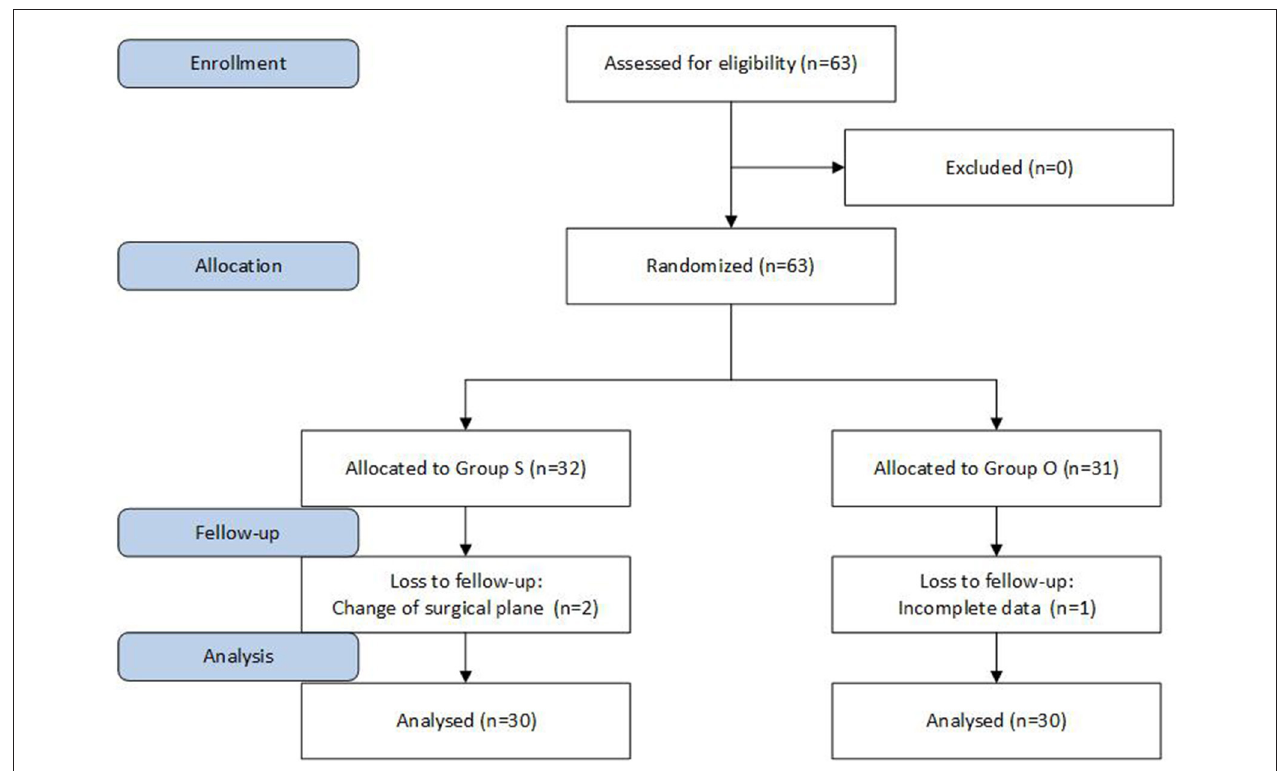
FIGURE 1 | Summary of protocol.